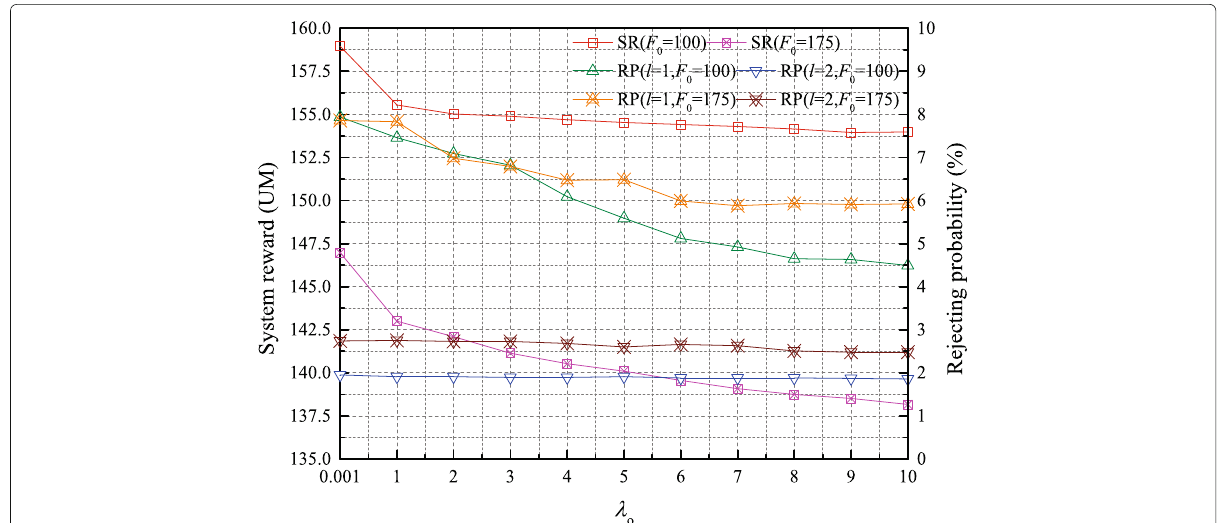
Fig. 12 SR and RPs under different radio resource variation rates. This figure shows the impacts of the radio resource variation rate on the evaluation